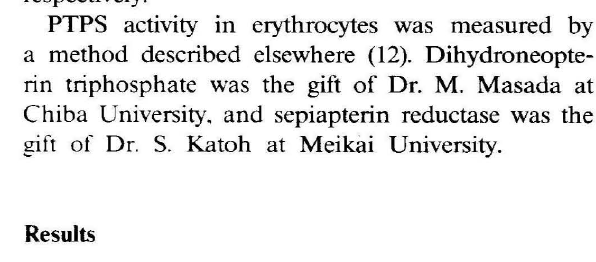
Figure 2. Response of serum levels of phenylalanine to oral tetrahydrobiopterin (BH4) loading (2.4 mg/kg) of patients. ., Case 1; 4, case 2; . , case 3 (BH4 deficiency). 0, Case 4 and .6, case 5 (persistent hyperphenylalaninemia). 0 , case 6 (classi cal